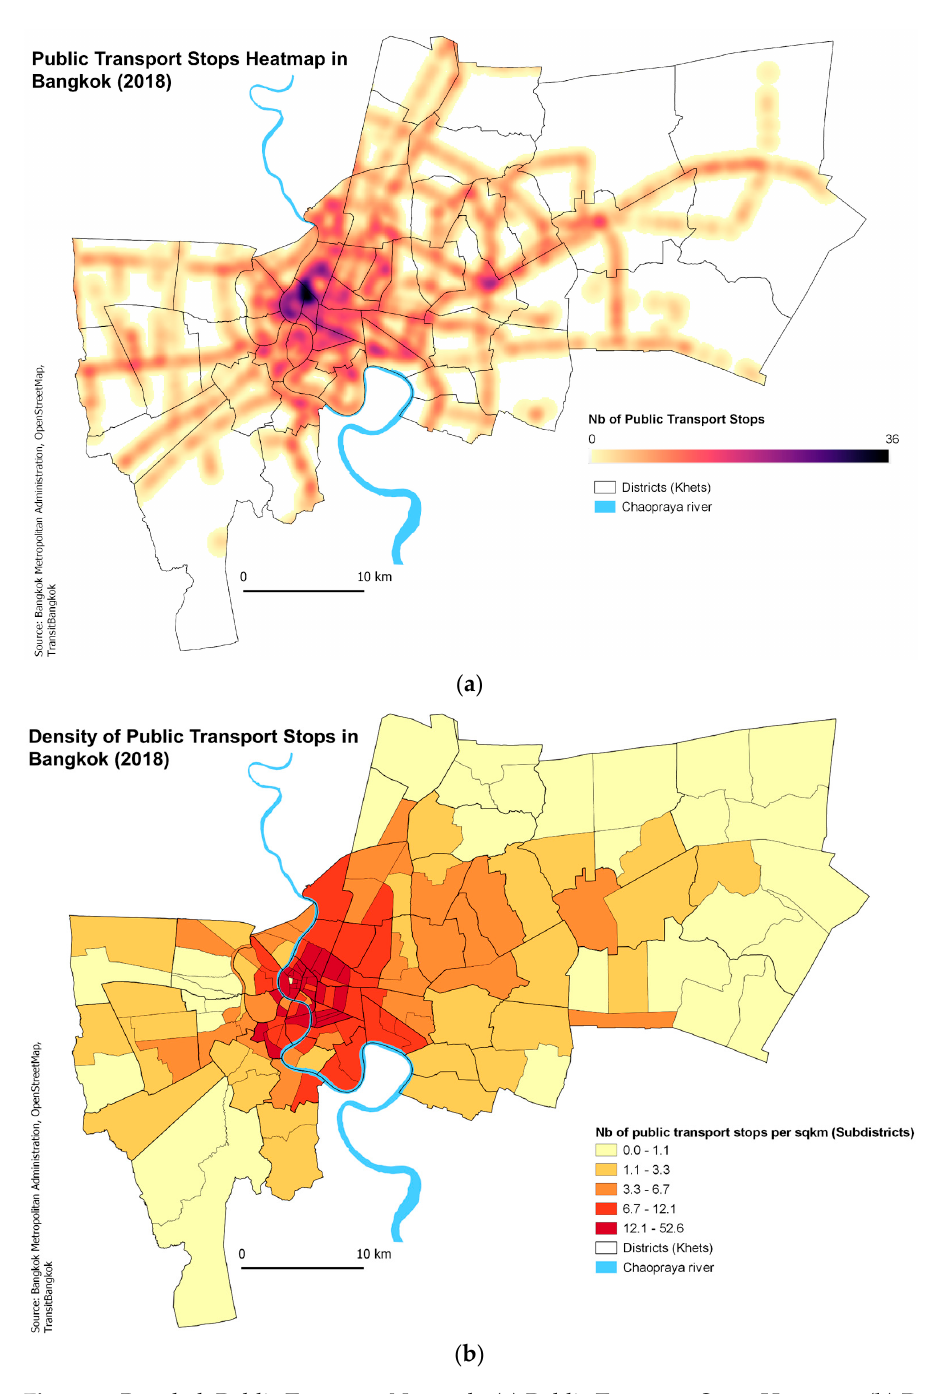
Figure 3. Bangkok Public Transport Network: ( a ) Public Transport Stops Heatmap, ( b ) Density of Public Transport Stops across subdistricts.